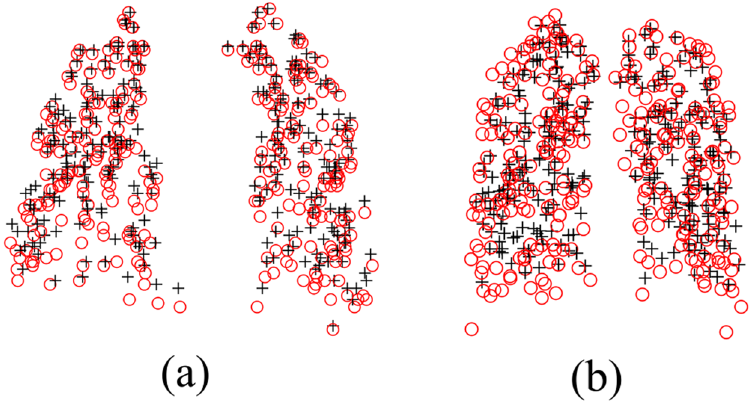
Figure 6. Examples of 3D cloud-like point sets extracted from thoracic 4D CT images. Each subject contains a pair of 3D lung point sets with 300 points both in template set and target set respectively. The target point sets are extracted from images of the maximum inhalation phase and the template point set are extracted from images of the maximum exhalation phase. We denote the target points with red “o” and the template ones black “ + ”. ( a) An example of the 4D CT lung dataset used in the quantitative evaluation. ( b ) An example of the COPD